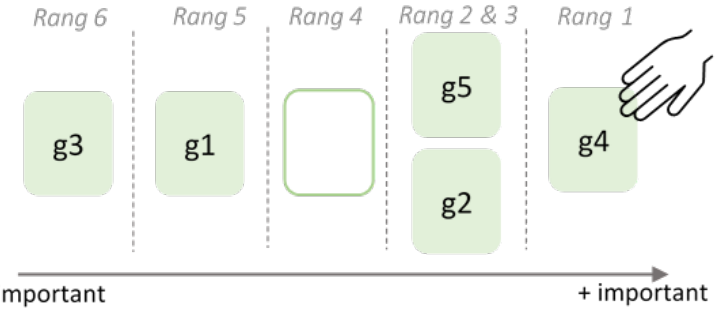
Figure 7. Schematic representation of the SRF weighting procedure.